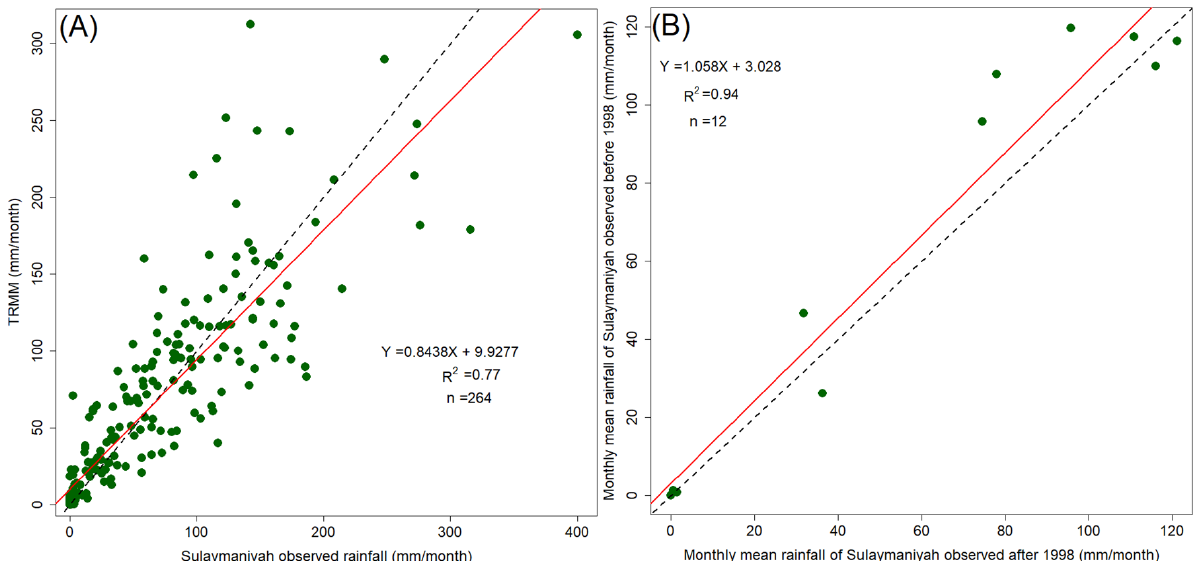
Figure 3. Correlation between rainfall data collected at the Sulaymaniyah meteorological station and the corresponding cell of the TRMM data; ( A ) all months and ( B ) mean of the months of the year for the period between September 1998 and August 2019 [79]. Table 3. Rainfall and runoff erosivity (R) factor models were tested in this study.